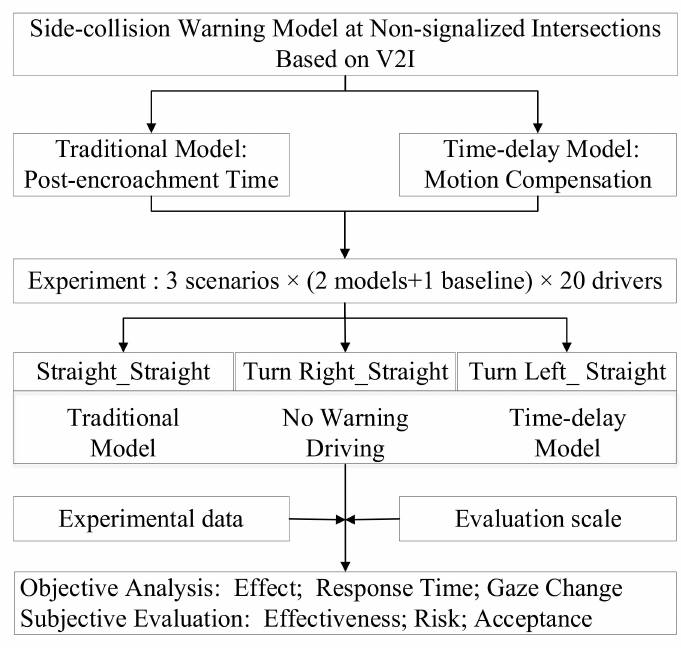
Figure 1. The overall framework of this study. V2I (Vehicle-to-Infrastructure) refers to the communi- cation between the vehicle and the